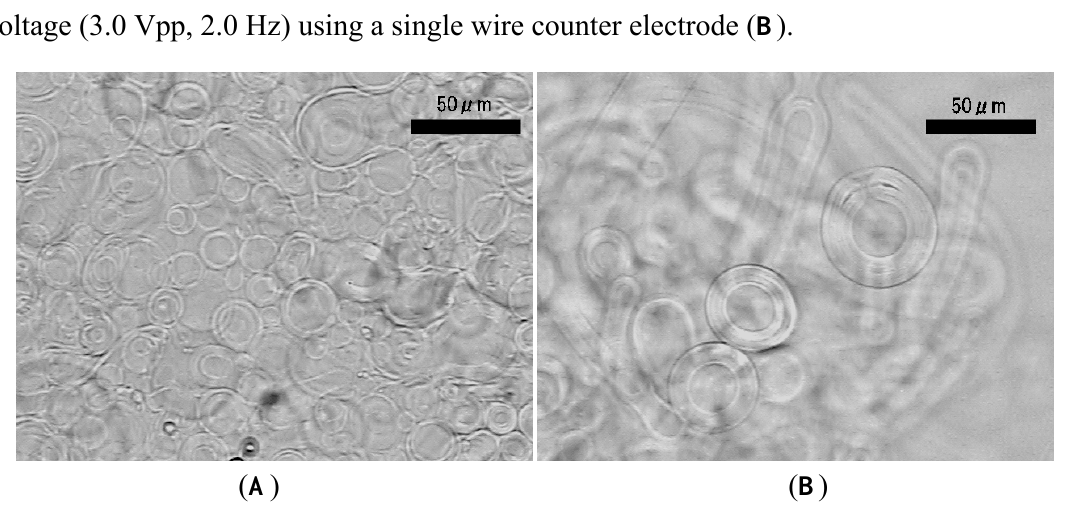
Figure 5. Irregular membranous objects formed by spontaneous swelling of lipid deposit on a planar formation electrode without applied electric voltage ( A , 120 min).